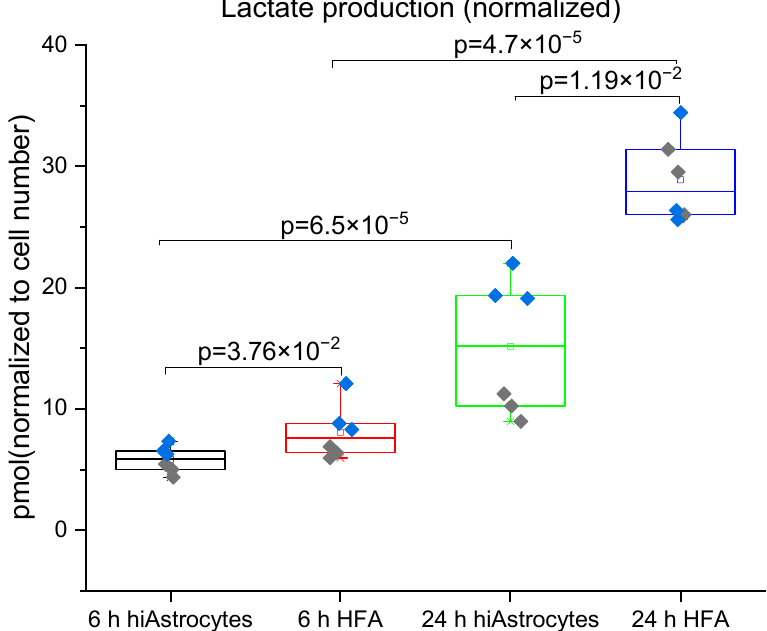
Figure 4. Lactate production for hiAstrocytes and HFA using a flow-based biosensor: Lactate production of hiAstrocytes and HFA after 6 h and 24 h treatment with defined media. Data were normalized to estimated cell numbers and relative dsDNA content of the samples at 24 h. Data are presented both as a box indicating the 25th–75th percentile, including a median line with 95% CI for the whiskers, with the addition of individual data points where colors represent independent experimental rounds. Corresponding p-values are presented in the graph, with a significance cut-off of 1 × 10 − 2 to correct for multiple comparisons.